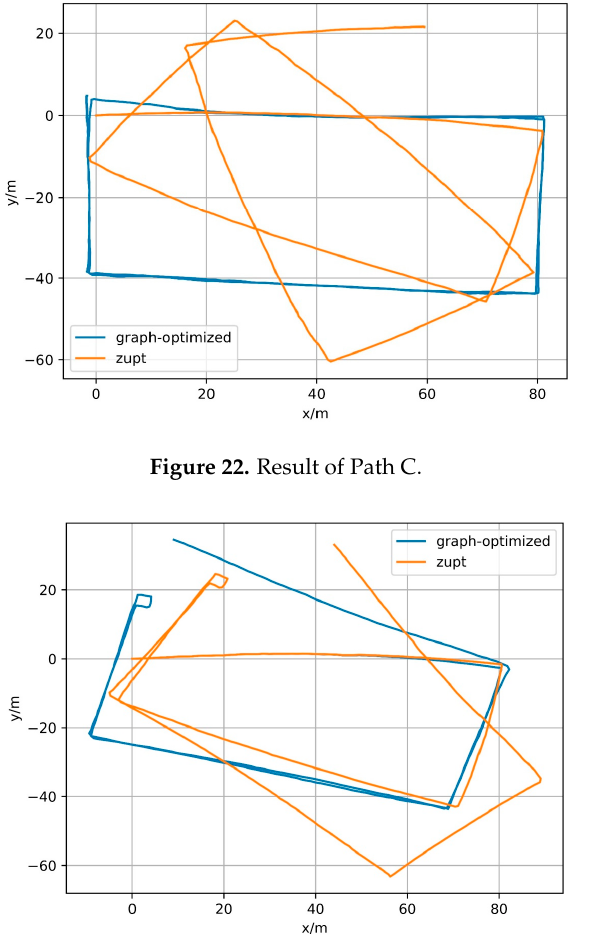
Figure 23. Result of Path D. Table 1. Accuracy of each trajectory.